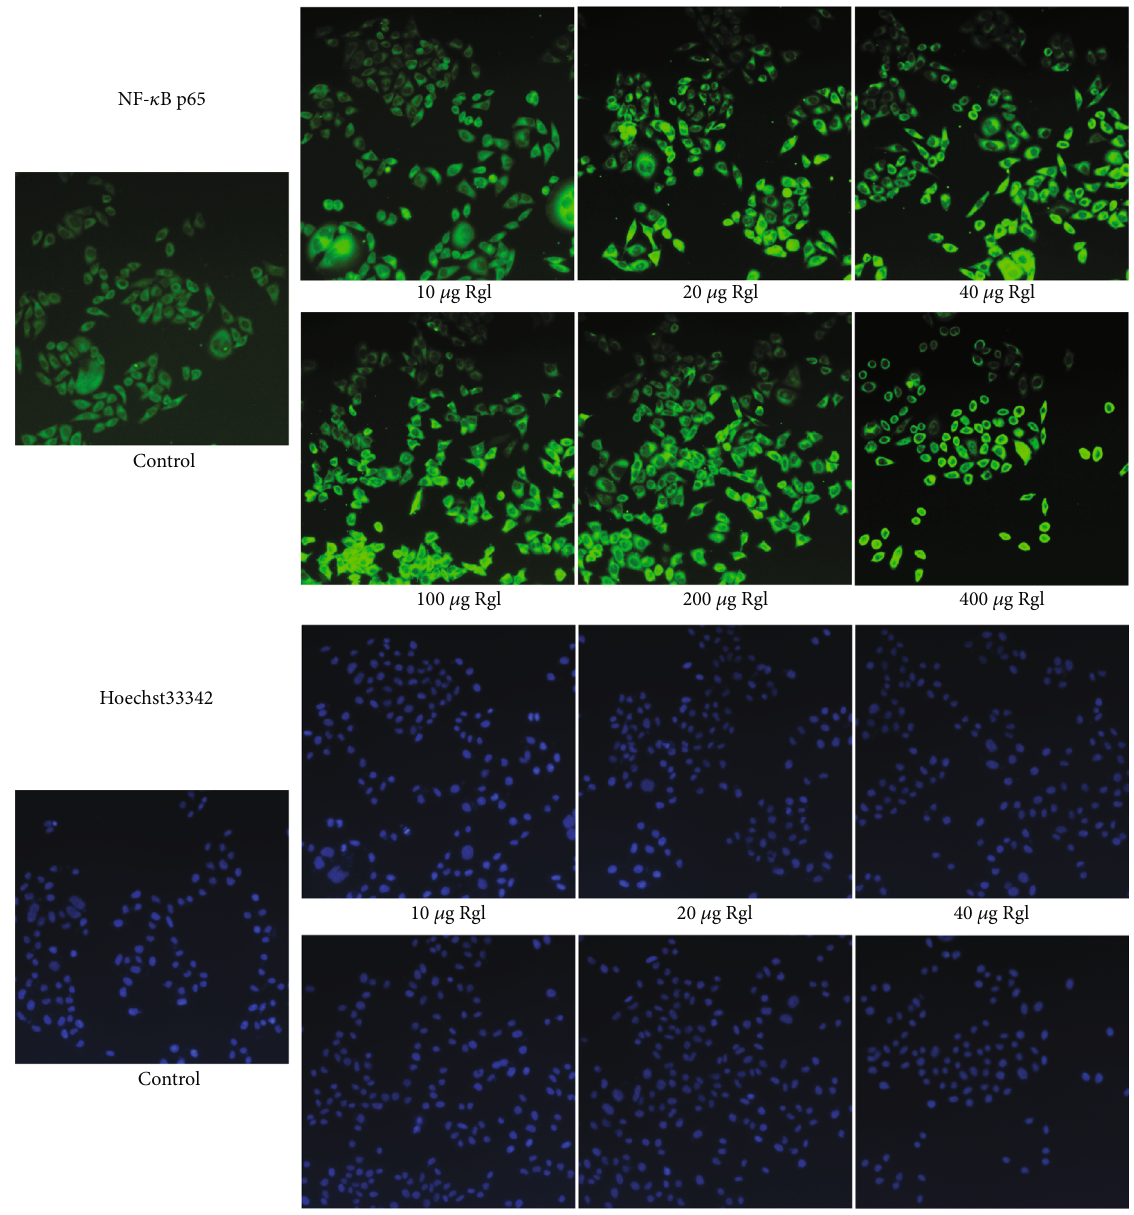
Figure 6: Rg1 (1 mg) was dissolved in 1 mL PBS and then diluted in gradient with culture medium. Cells were incubated with medium containing with or without Rg1 at 10, 20, 40, 100, 200, and 400 μ g/mL for